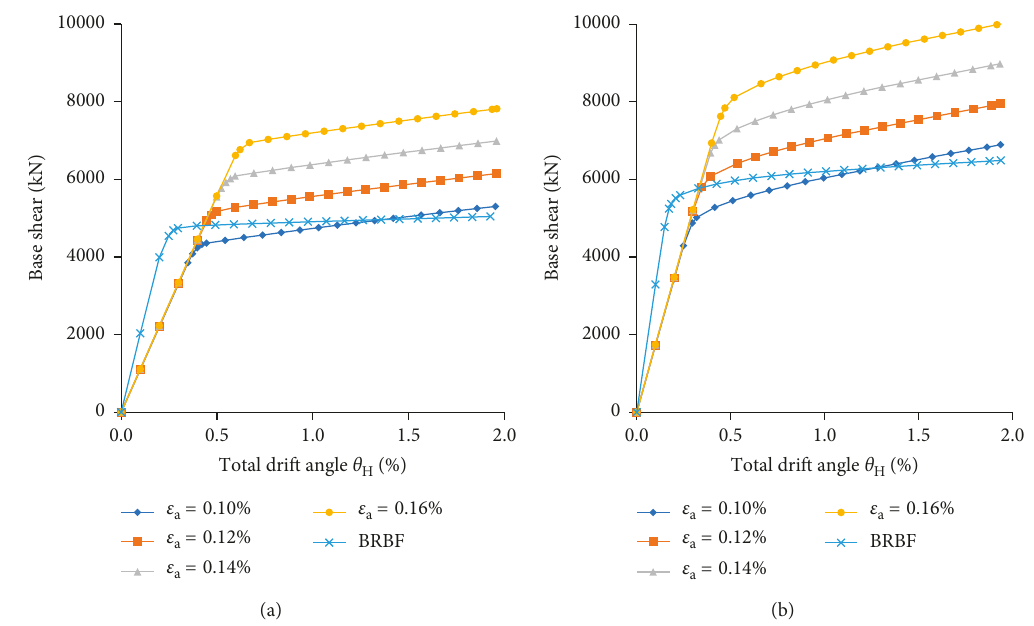
Figure 17: The effects of ε on the base shear response of 16-story SC-TOBFs: (a) LD-1 and (b) LD-2. a